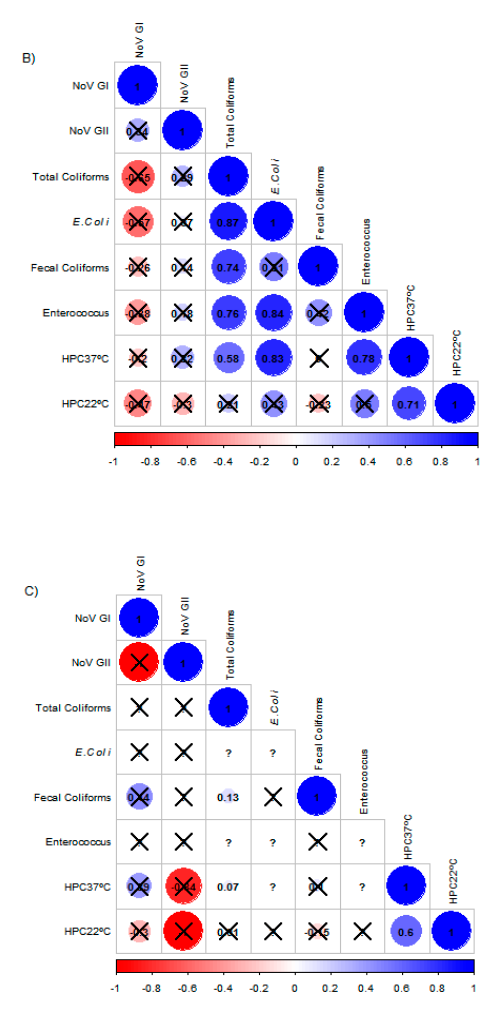
Figure 1. Graphical display of the correlation matrix of the microbiological parameters tested in each wastewater treatment phase ( A ) WW1, ( B ) WW2, and ( C ) WW3). The “?”—means “Not enough finite observations”.